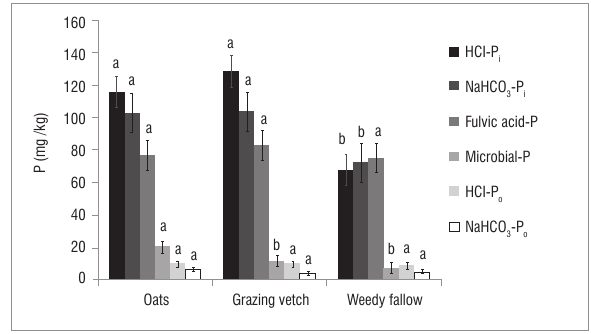
Figure 1: Effects of winter cover crop type on labile and moderately labile soil P pools.